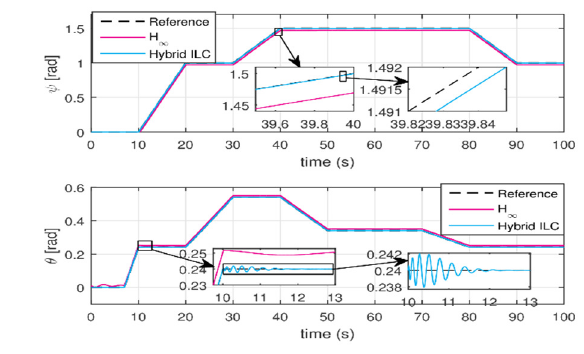
Fig. 9: Reference Tracking with Sharp Edges